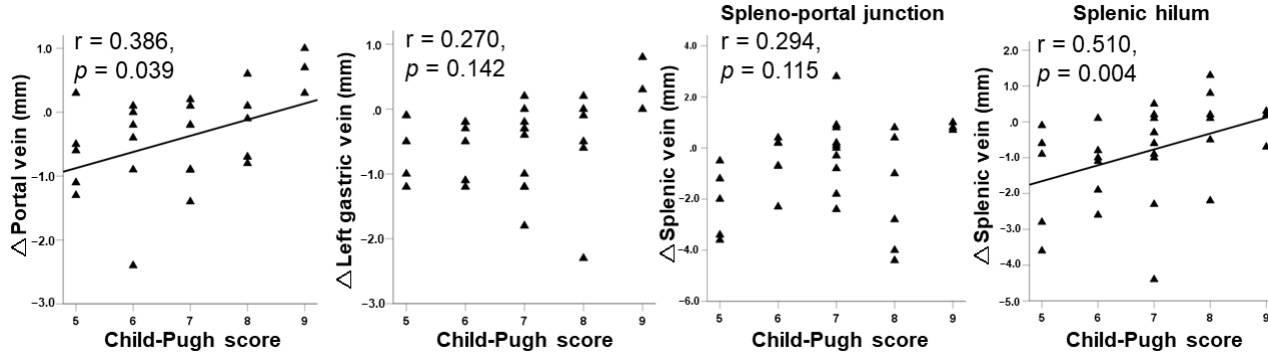
Figure 4. The relationship between changes in portal hemodynamics after partial splenic embolization and Child – Pugh score.